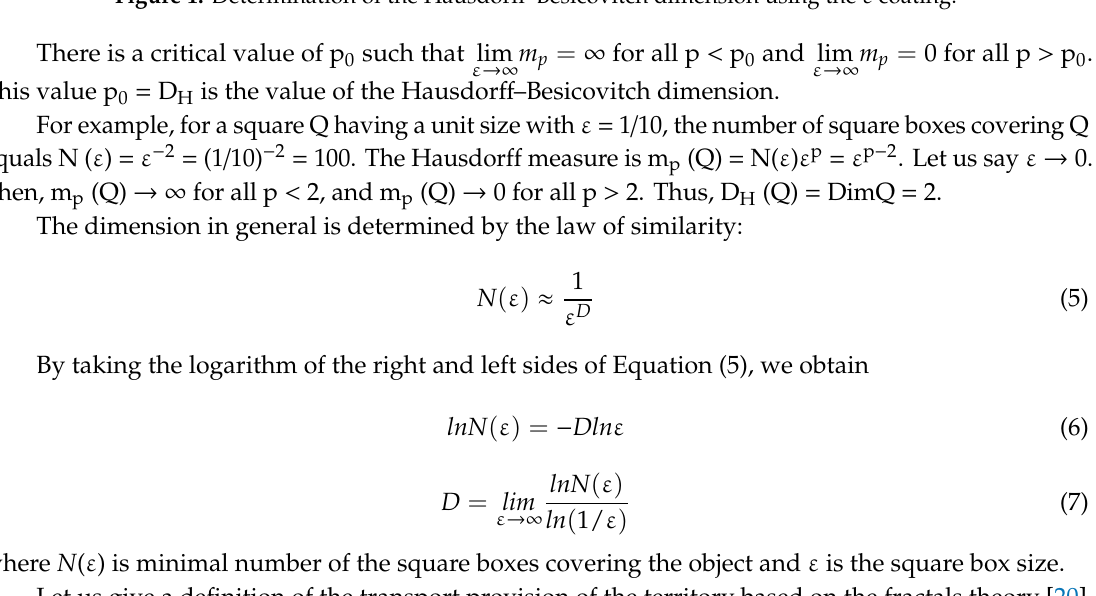
Figure 1. Determination of the Hausdorff–Besicovitch dimension using the ε coating.